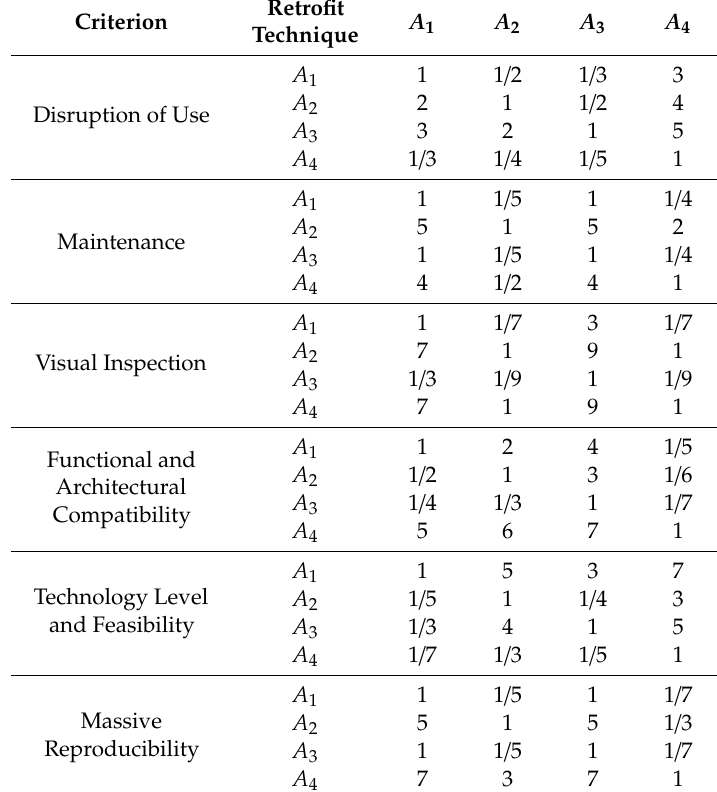
Table 6. Binary Comparisons to Build the Preference Matrix (4 × 4) for Each Qualitative Criterion.